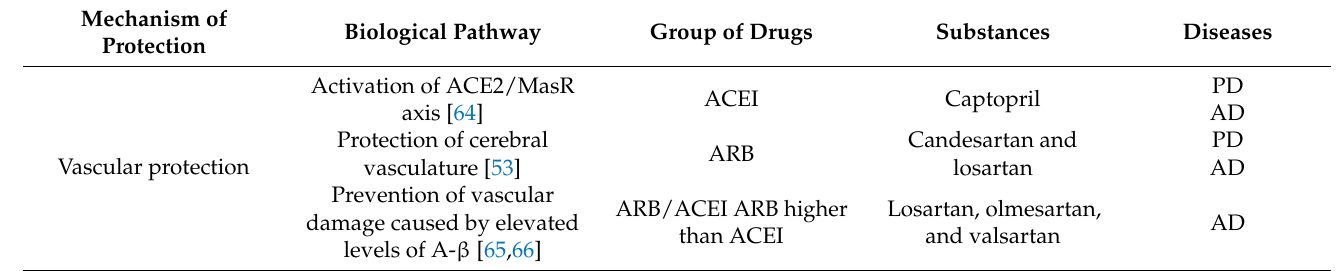
Table 1. Protective mechanisms of RAS pharmacological modulators via an increase in vascular